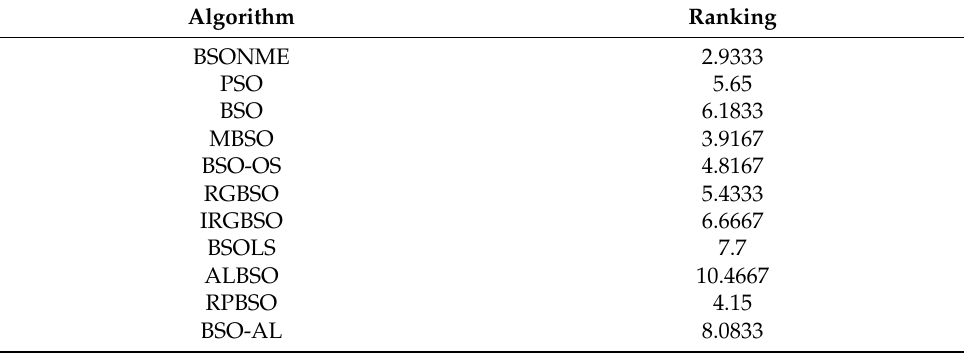
Table 14. Average ranking of the algorithms